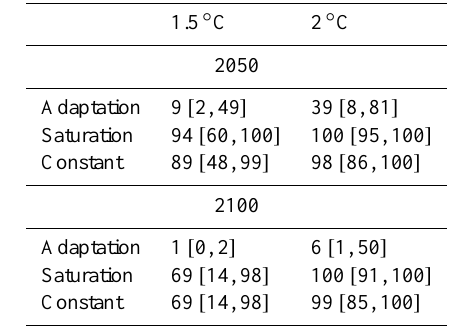
Table 3. Fraction of reef cells at risk of long-term degradation due to coral bleaching in 2050 and 2100 for three different assumptions about the adaptive capacity and susceptibility of corals to ocean acidification as described in Sect. 7.1 in percent. Median projec- tions and the 66% range (in square brackets) are given, accounting also for uncertainties in global mean temperature